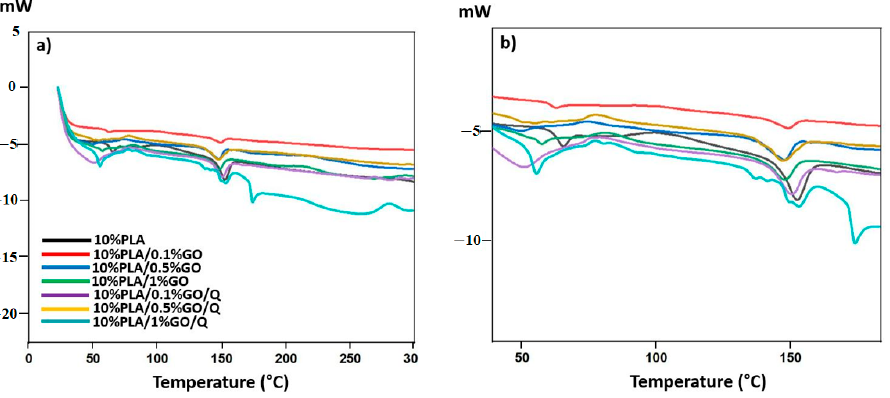
Figure 4. DSC thermograph of all the microfiber scaffolds ( a , b